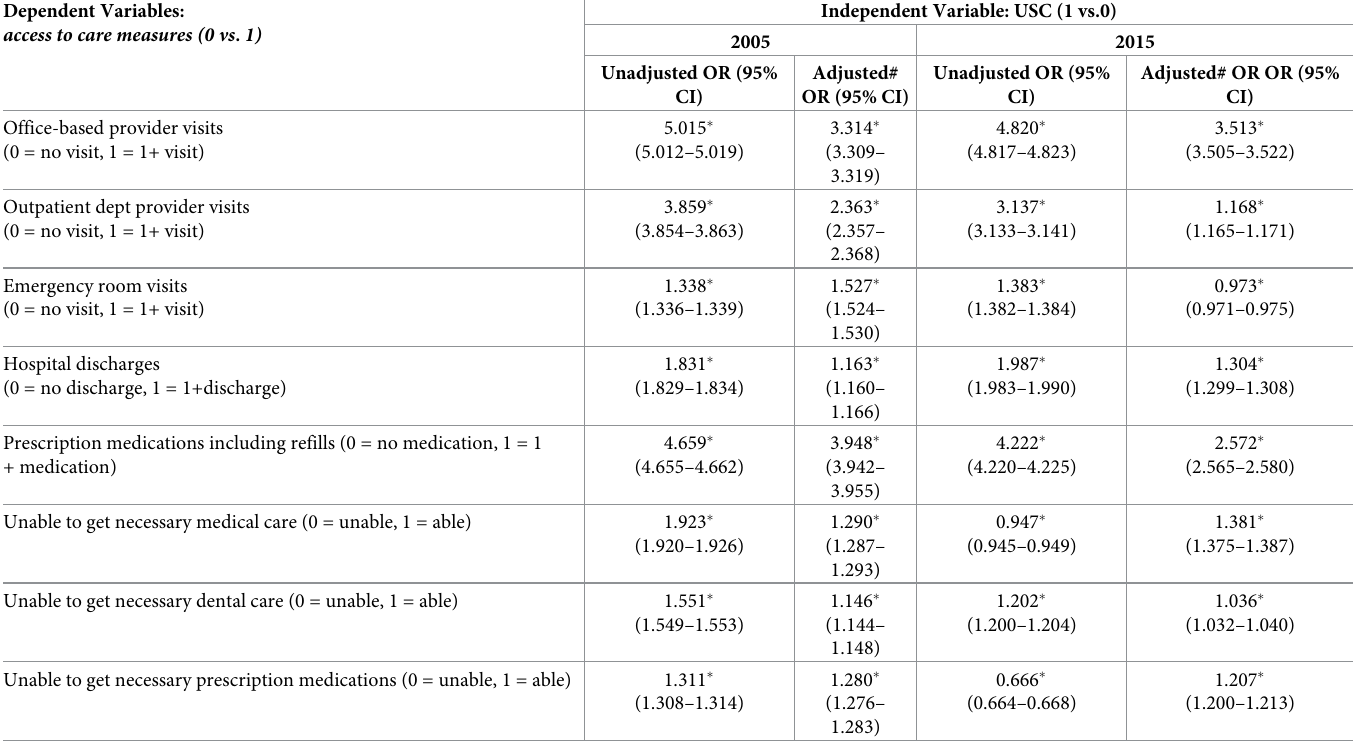
Table 4. Logistic regression on Usual Source of Care (USC) by access to care: 2005 vs.